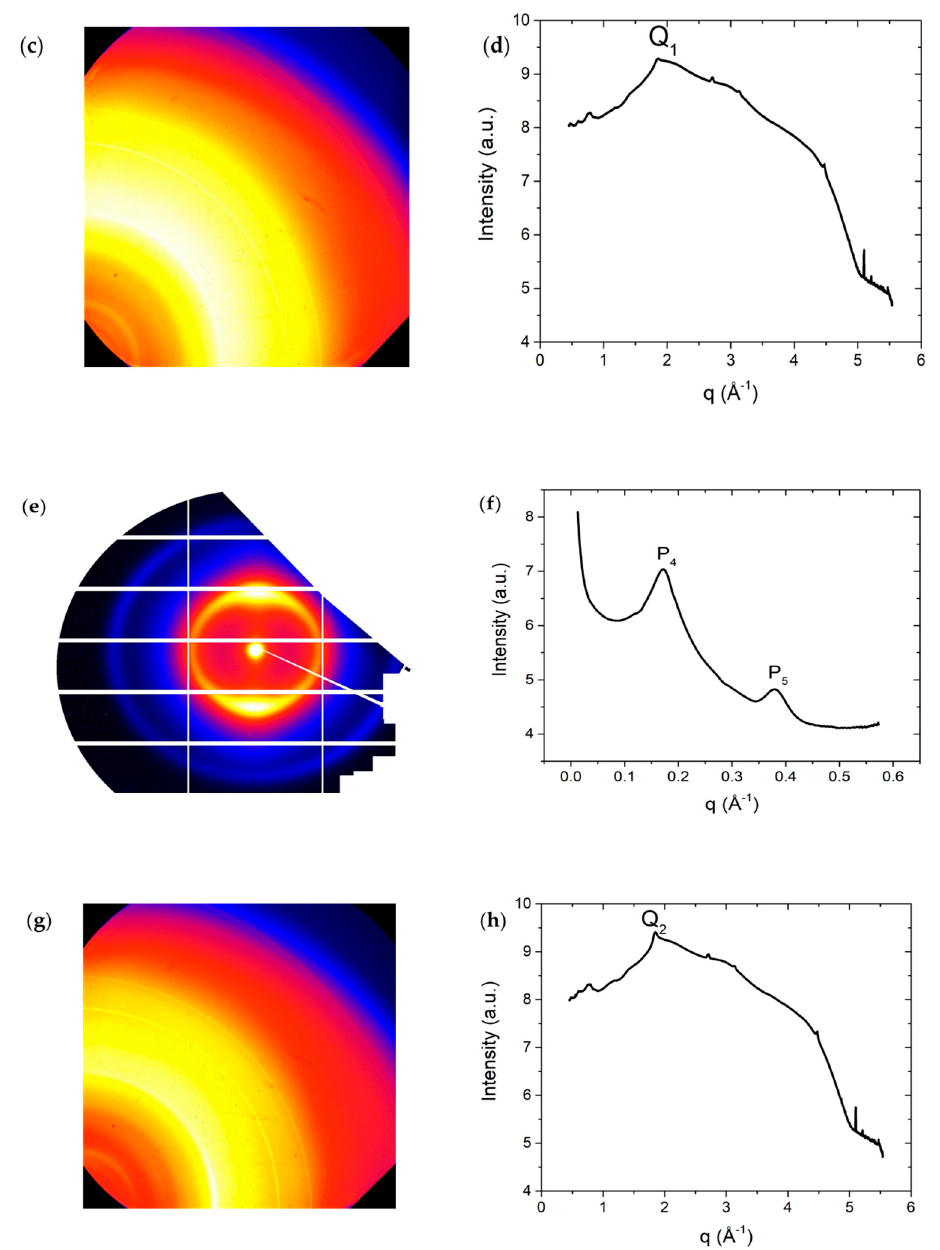
Figure 3. X-ray data for DSCG 0.34 mol/kg + PEG 0.011 mol/kg at T = 44.5 ◦ C. ( a ) Diffraction pattern from small angle X-ray scattering (SAXS); ( b ) Intensity profile from SAXS; ( c ) Diffraction pattern from wide-angle X-ray scattering (WAXS); ( d ) Intensity profile from WAXS; ( e ) Diffraction pattern from SAXS at T = 40.7 ◦ C; ( f ) Intensity profile from SAXS at T = 40.7 ◦ C; ( g ) Diffraction pattern from WAXS at T = 40.7 ◦ C; ( h ) Intensity profile from WAXS at T = 40.7 ◦ C. Peak P 3 in ( b ), P 5 in ( f ), and the multiple peaks seen below q = 1 A − 1 in ( d , h ) correspond to background scattering from Kapton windows and do not characterize the DSCG structure.